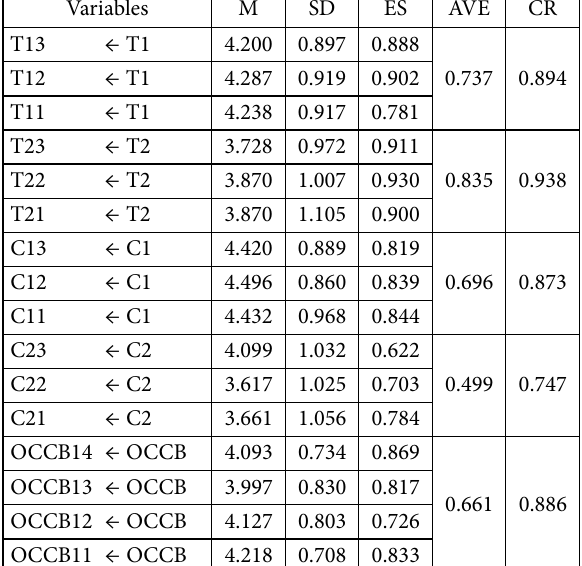
Table 4. Goodness-of-fit of the measurement model Table 5. Descriptive statistics, construct reliability, and